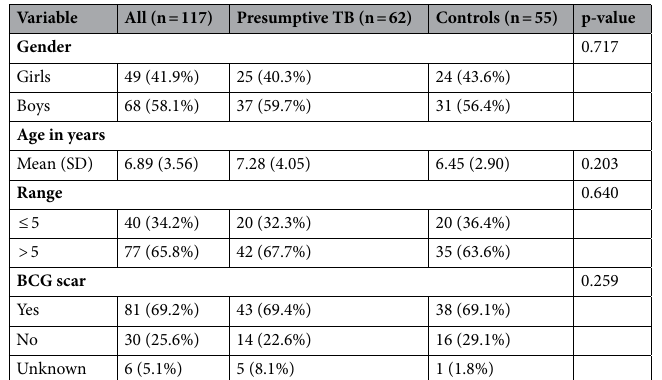
Table 1. Demographic and clinical characteristics of the study participants. Categorical variables expressed as number of subjects (n) and percentage (%), and quantitative variables expressed as median and standard deviation (SD). TB tuberculosis, BCG Bacillus